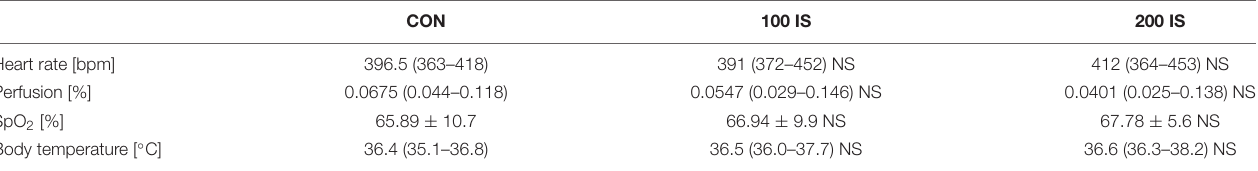
TABLE 5 | Impact of IS on cardiorespiratory parameters. CON 100 IS